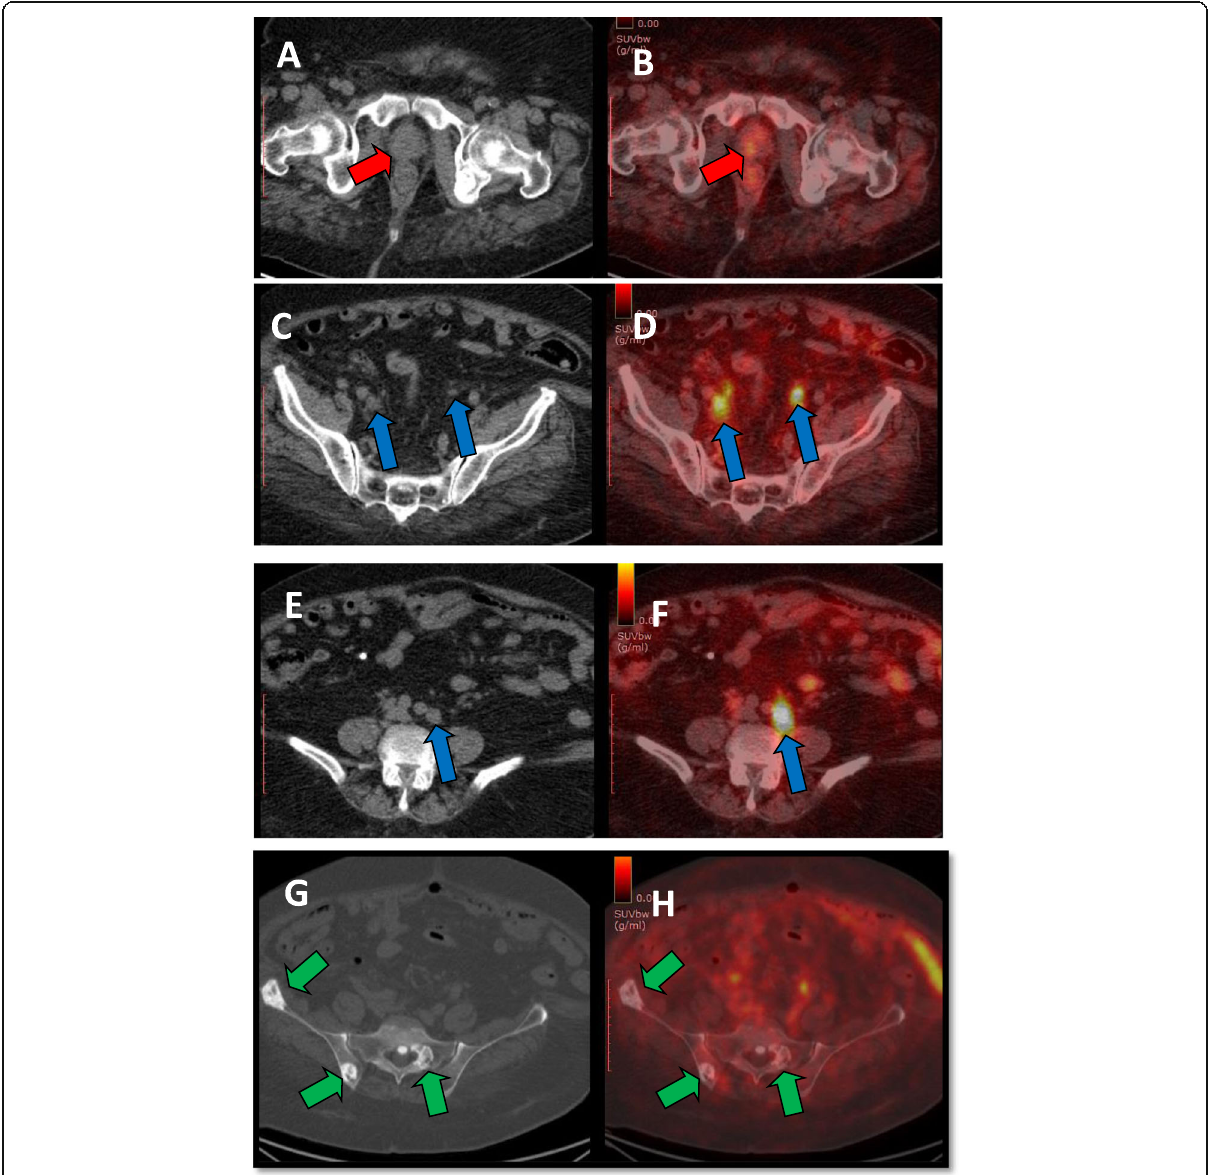
Fig. 3 Axial non-contrast CT and PET-CT images for a 79-year-old male patient with history of prostate cancer for which he had radiotherapy and hormonal therapy. Images a and b showed 68Ga-PSMA activity by small prostatic lesion with SUVmax = 2.5 (red arrows) suggesting small residual neoplastic lesion. Images c – f showed 68Ga-PSMA activity by multiple small bilateral external and common iliac LNs; the most active shows SUVmax = 15.4 (blue arrows). The PET-CT revealed metastatic deposits in the iliac lymph nodes despite their subcentimetric size in CT. Images g and h showed multiple sclerotic osseous lesions involving the right iliac bone and sacrum with no 68Ga-PSMA activity (green arrows) denoting inactive metastatic